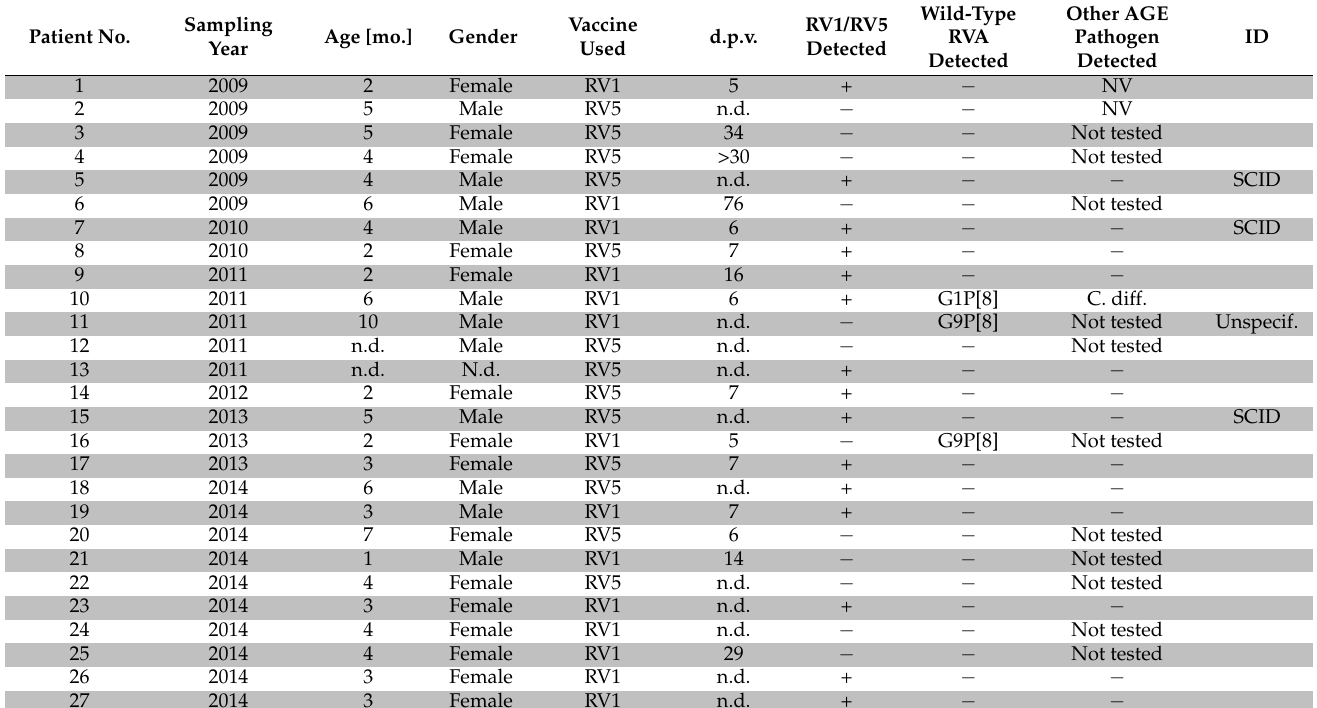
Table 2. Patients and results of samples from 2009 to